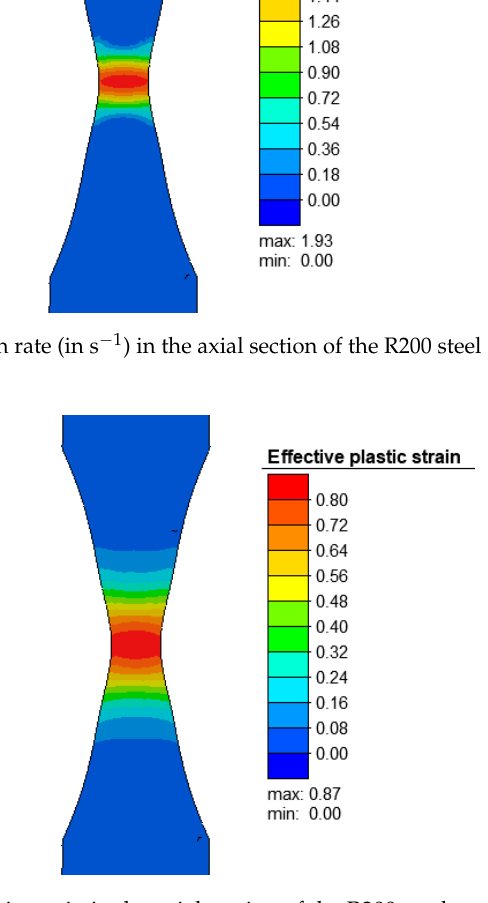
Figure 8. Effective plastic strain in the axial section of the R200 steel sample under the tensile test at 1100 °C. Materials 2019 , 12 , x FOR PEER REVIEW